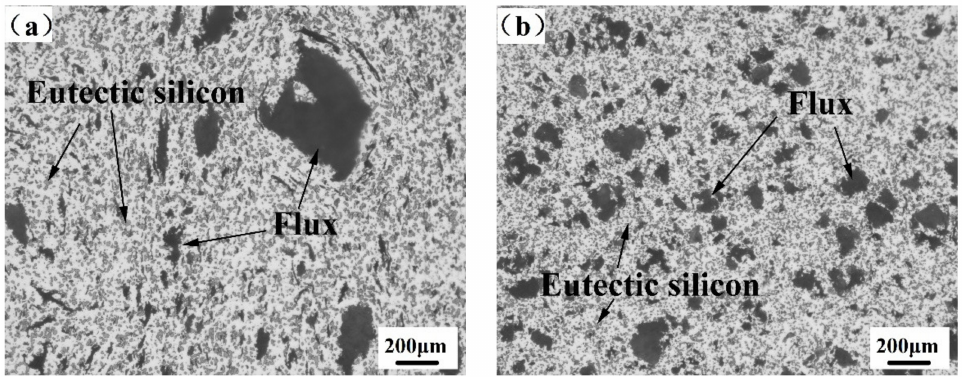
Figure 7. Micro-morphology of the composite brazing filler metal: ( a ) The PM brazing filler metal; ( b ) The SKA brazing filler